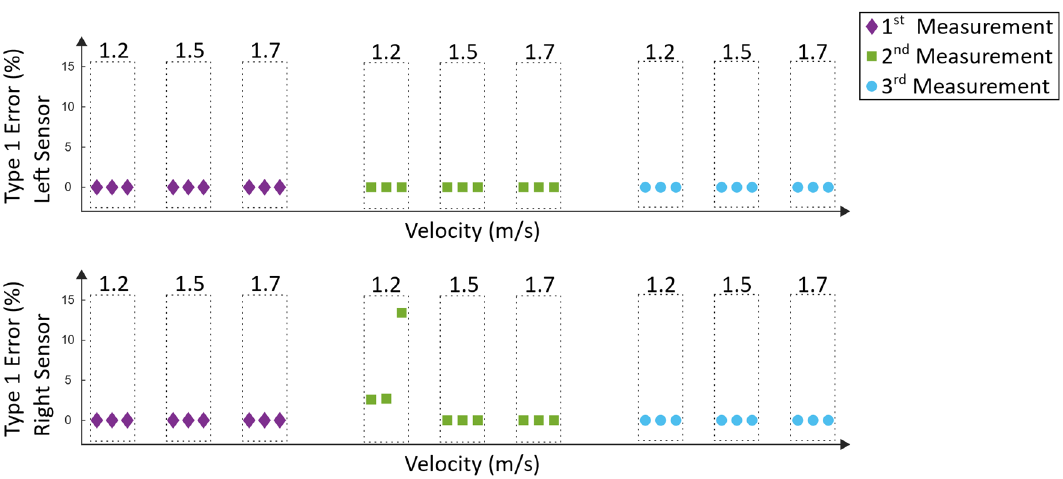
Figure 23. Type-1 errors of the Lokomat measurements.